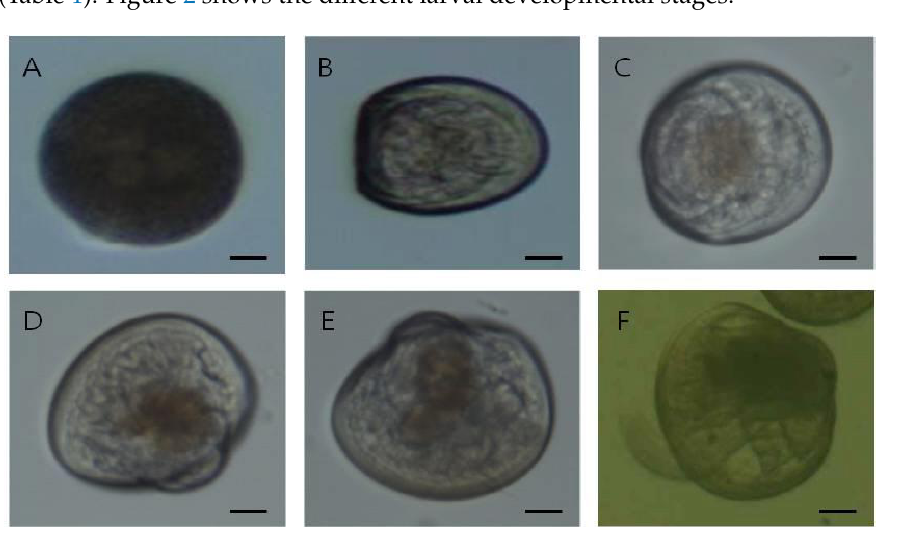
Figure 2. Developmental stages of Mactra chinensis — ( A ): fertilized egg (50 –60 μm) ; ( B ): D-stage larva (70 –100 μm shell length (SL)); ( C ): early umbonal stage (110 –140 μm SL) ; ( D ): umbonal stage (150 –170 μm SL) ; ( E ): late umbonal stage (180 –220 μm SL) ; and ( F ): settled (metamorphosing) stage (300 –350 μm SL). The scale bar indicates 50 μm.